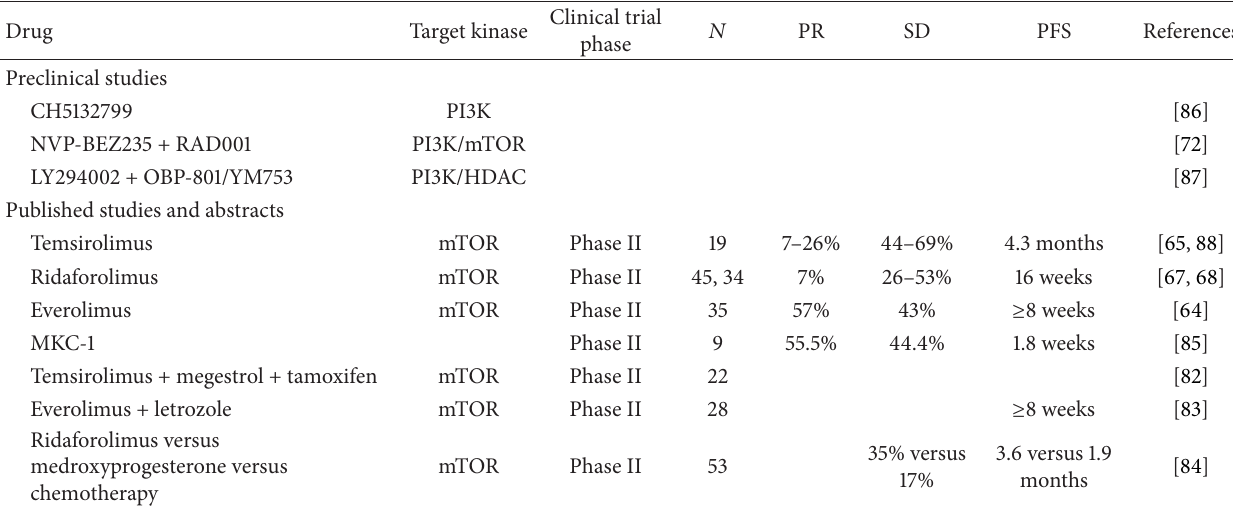
Table 1: PI3k/Akt/mTOR inhibitors in preclinical and clinical studies.